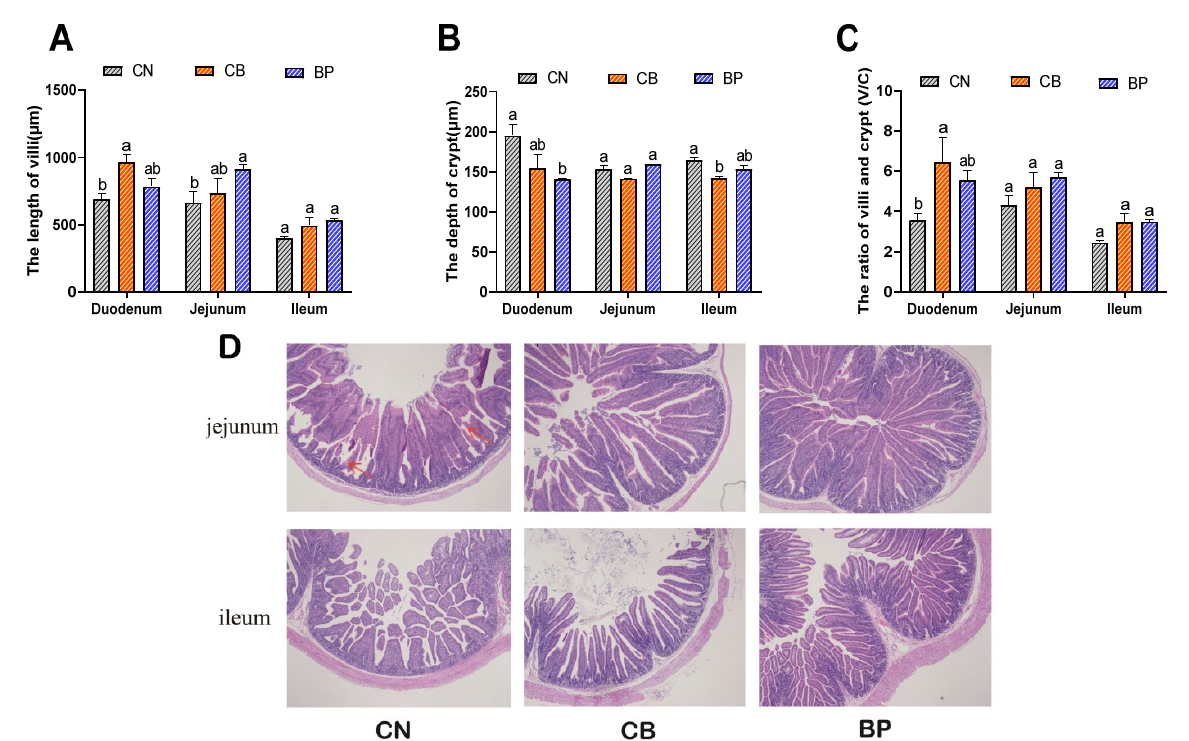
Figure 4. Effects of CN, CB, and BP on the morphology of the small intestinal mucosa in rabbits. ( A – C ) Villus length and crypt depth in the small intestinal mucosa, as well as the ratio of villus length to crypt depth. ( D ) H&E-stained section images (40×) of the jejunum and ileum. CN, rabbits were fed a basal diet; CB, rabbits were fed a basal diet supplemented with Clostridium butyricum ; BP, rabbits were fed a basal diet supplemented with a bacteriophage cocktail (values are ex- pressed as the mean ± SE, n = 8; a,b Mean values within a row with unlike superscript letters were significantly different ( p < 0.05).